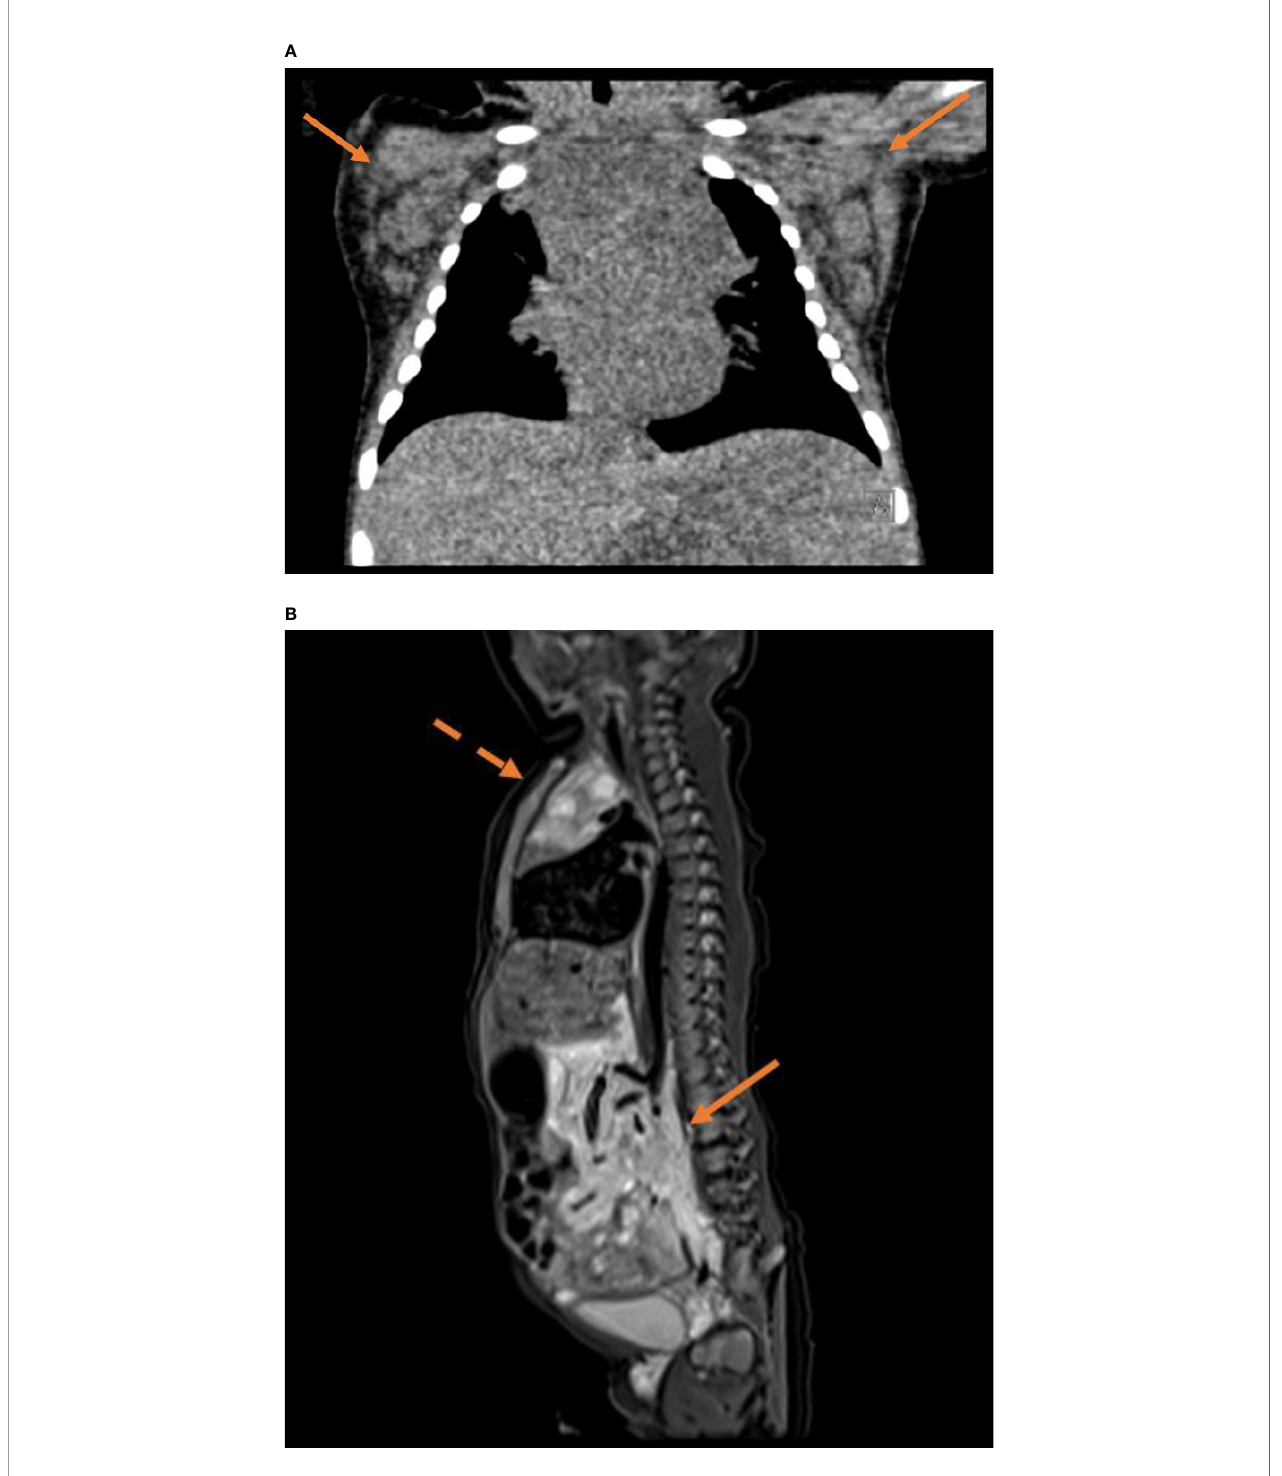
FIGURE 2 | (A) Noncontrast CT (80kV, 48mAs, FOV 170x130mm) with coronal reconstruction using a soft tissue kernel shows a distinct bilateral axillary lymphadenopathy (arrows) and a prominent inhomogeneous thymus. (B) Sagittal T2 STIR sequence of a whole body MRI (TE 33ms, TR 3800ms, FOV 300x300mm, matrix 256x256px) shows bulky hyperintense soft tissue masses surrounding the aortocaval and mesenteric vasculature (solid arrow). The enlarged thymus features multiple jagged-edged cystic lesions (dotted